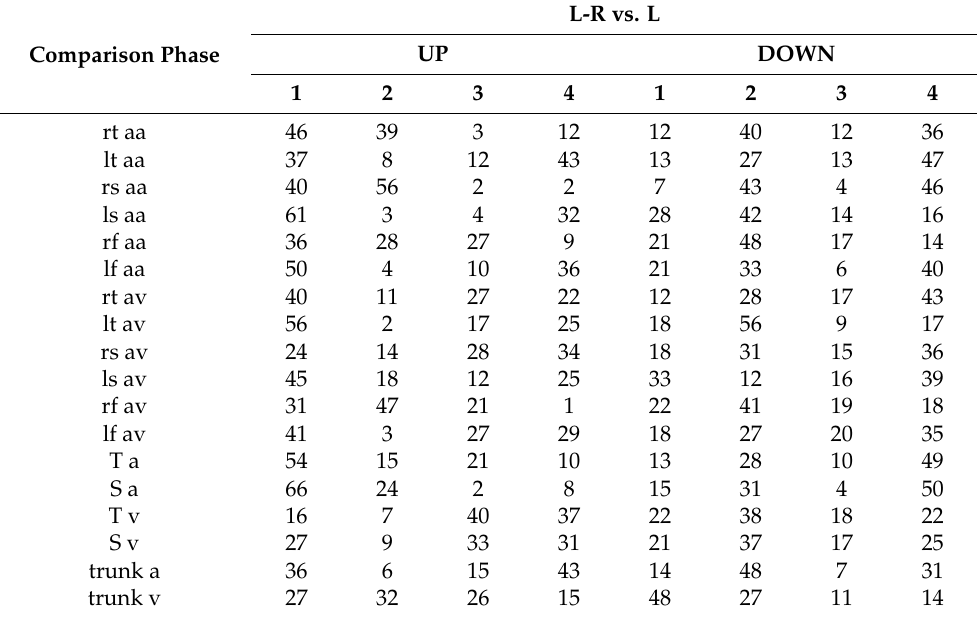
Table 6. Percentage of the significant difference points in each gait phase of each parameter (%).